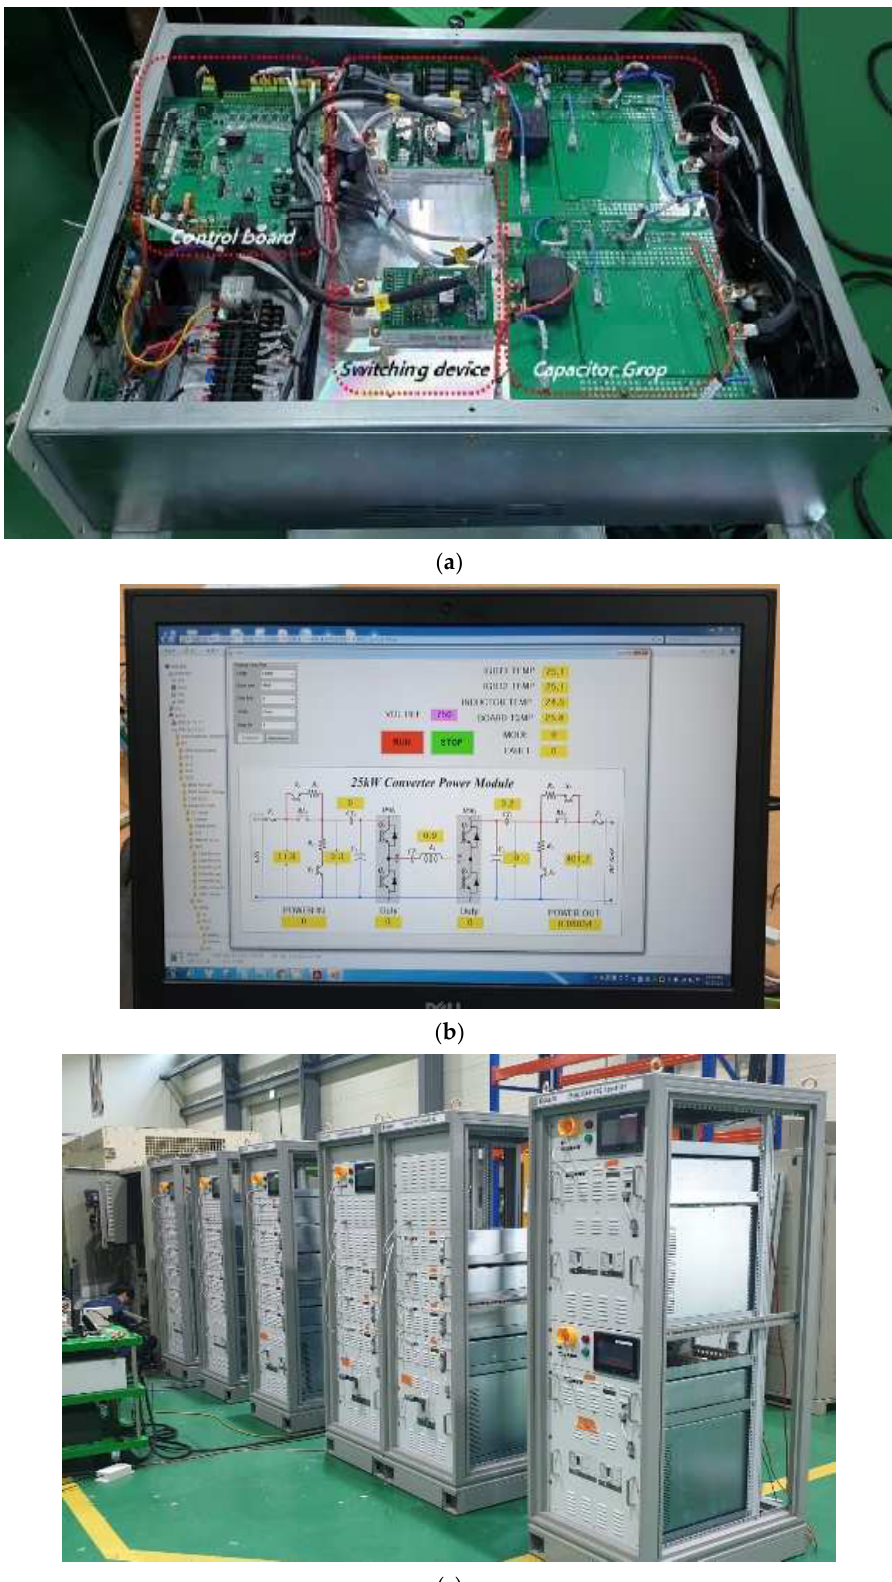
Figure 11. Bi-directional boost-buck system. ( a ): Bi-directional converter module. ( b ): Module monitoring system. ( c ): Bi-directional boost-buck